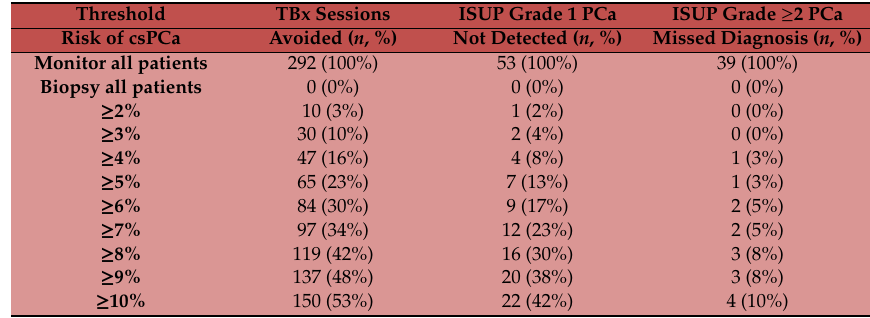
Figure 2. Decision curve for clinically significant prostate cancer in the targeted biopsy of the prediction model. Table 5. Performance and clinical utility of the prediction model: numbers of avoided TBx sessions, low ‐ risk PCa diagnoses, and missed csPCa using a risk threshold range of 2% to 10%.